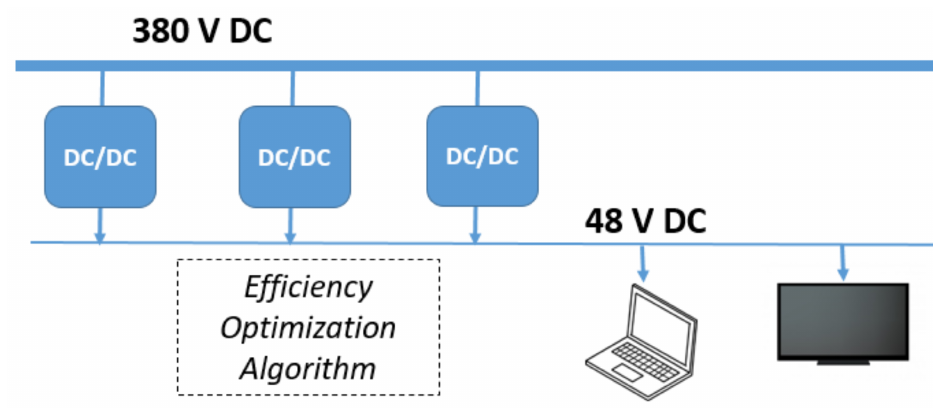
Figure 4. Example of DC-powered PoE lighting